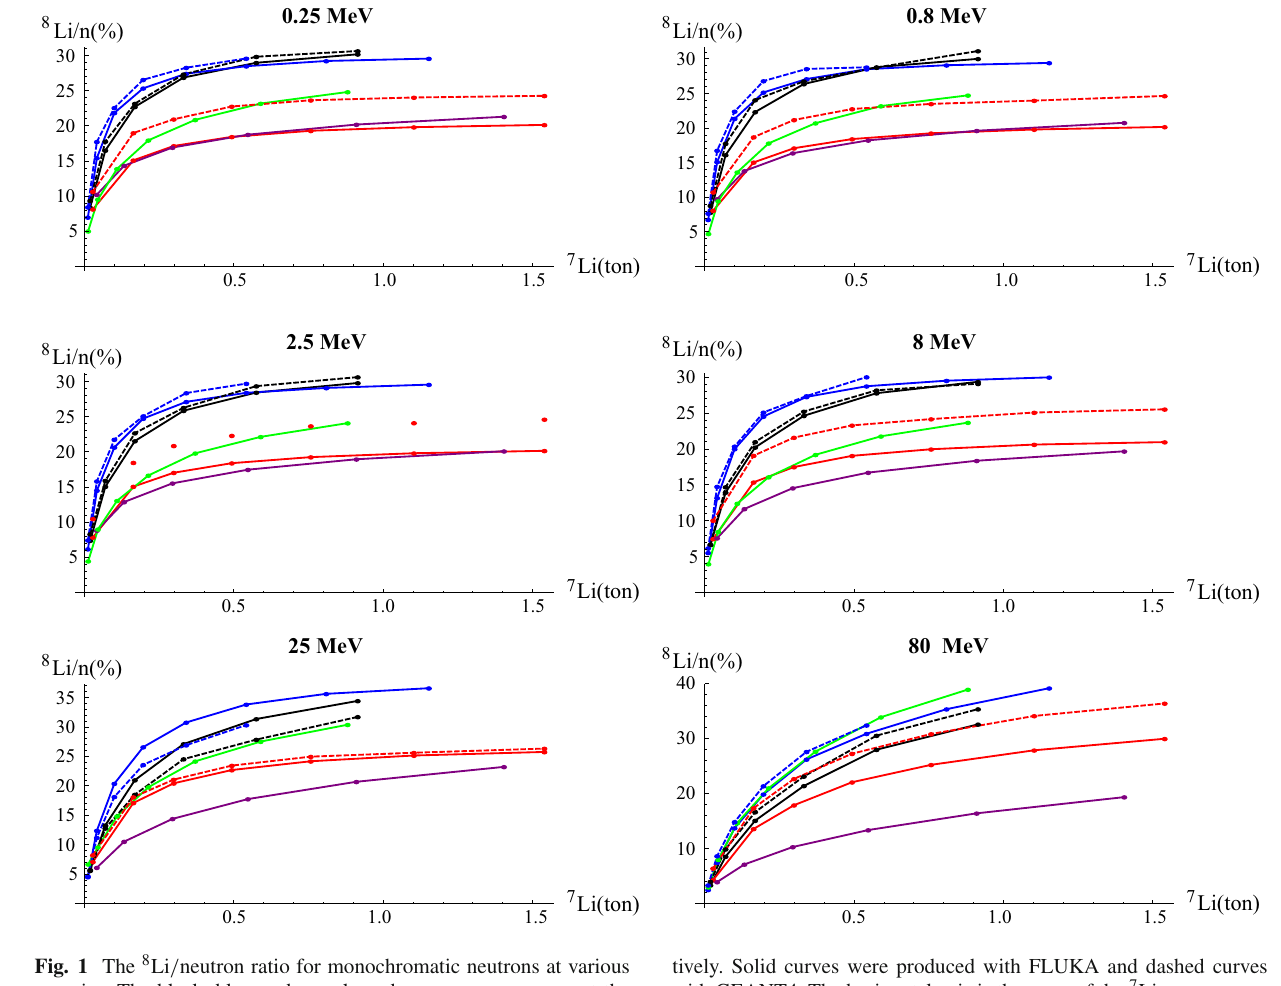
0.01 Fig. 2 The 8 Li / neutron ratio for monochromatic neutrons at various energies in LiOD (left) and FLiBe (right). The blue, yellow and green curves represent the 0.1, 0.5 and 1 ton of 7 Li respectively